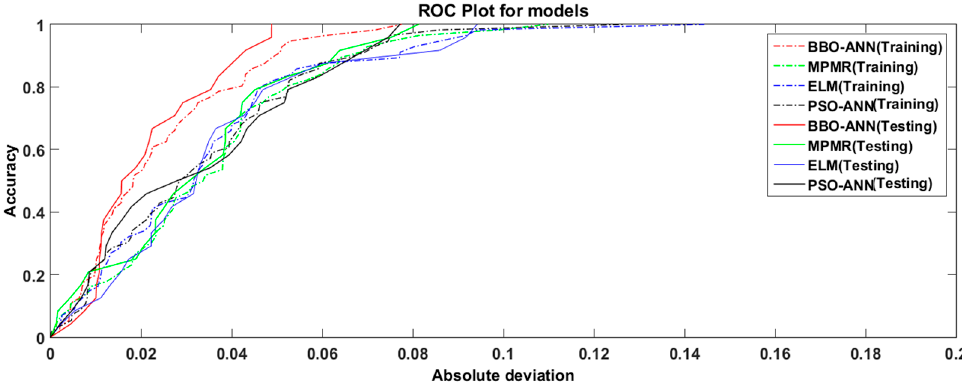
Figure 7. ROC plot displaying the accuracy versus deviation for predicted PPV values on the training and testing dataset using the predictive models.